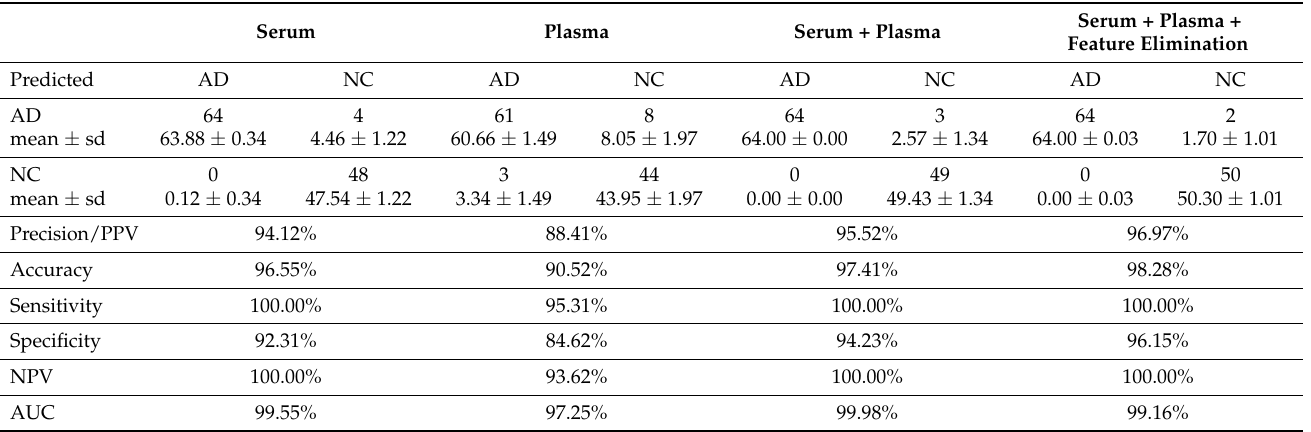
Table 3. Average performance for training set of 64 ADs and 52 NCs in the 10 times repeated 5-fold cross-validation